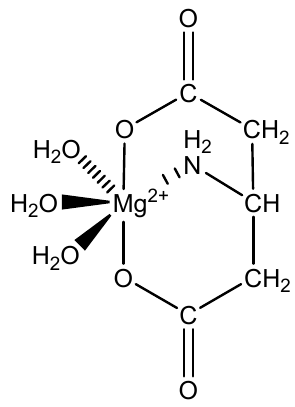
Figure 18. Illustrated structure of magnesium aspartate trihydrate